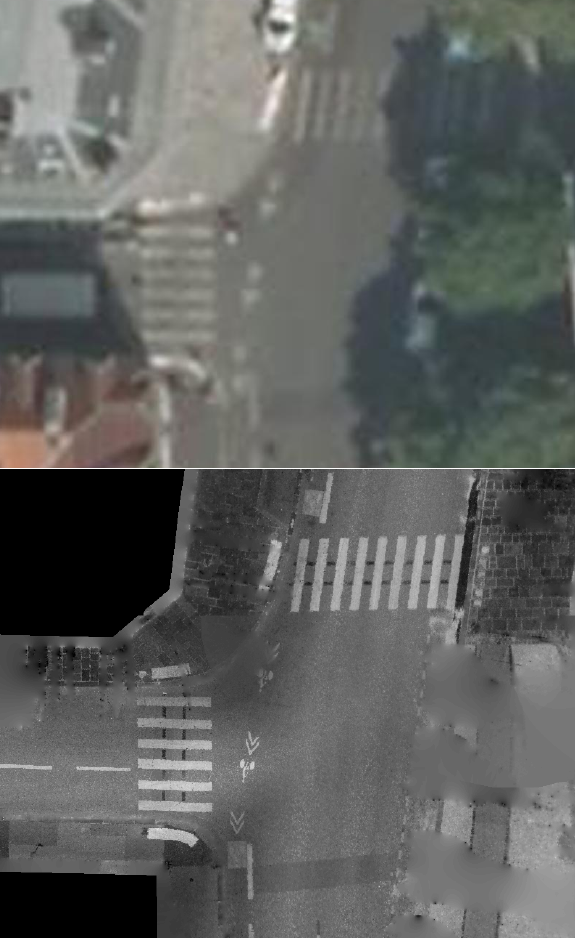
Figure 8: Comparison of a 20cm aerial orthophoto (top) with a MLS orthophoto